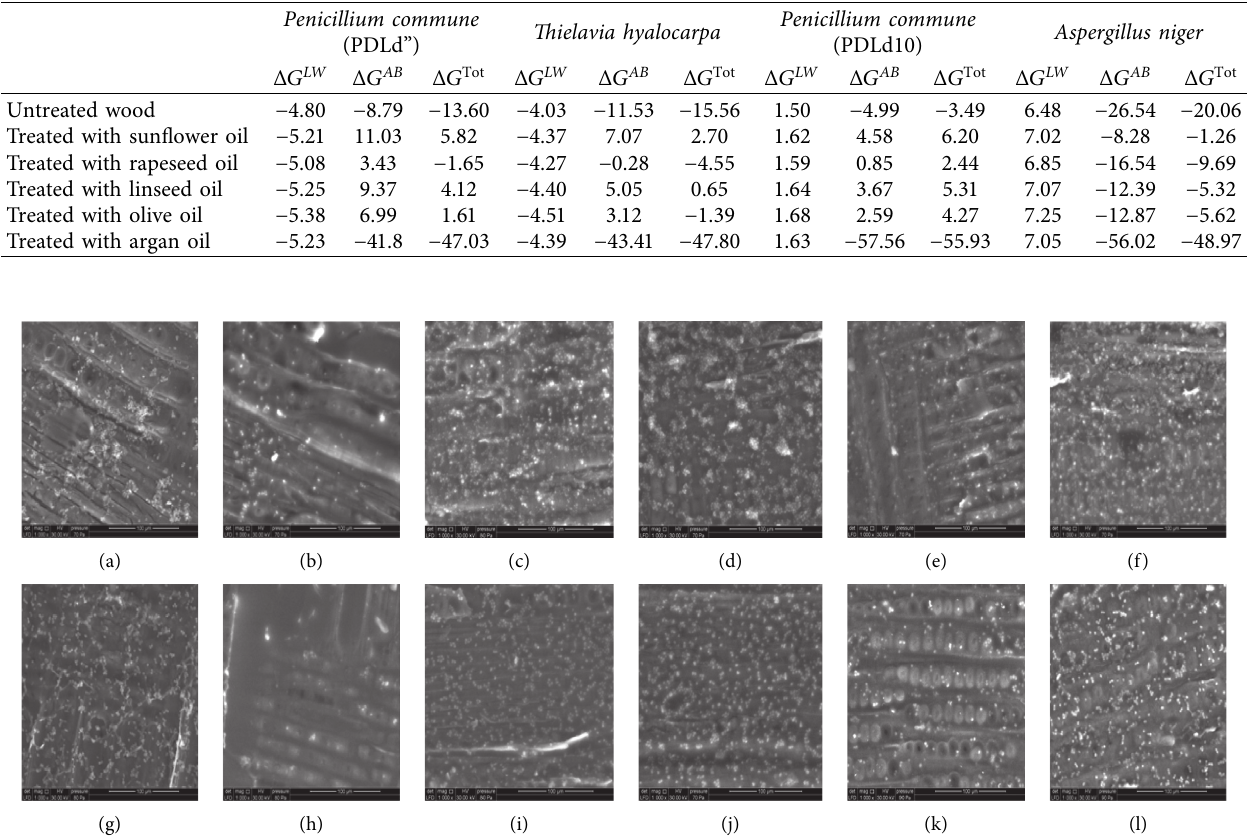
Table 5: The total interaction free energy ∆ G Tot , the polar forces of Lewis ∆ G AB , and apolar Lifshitz–van der Waals ∆ G LW of the adhesion of fungal strains studied for untreated and treated wood (in mJ/m 2 ).